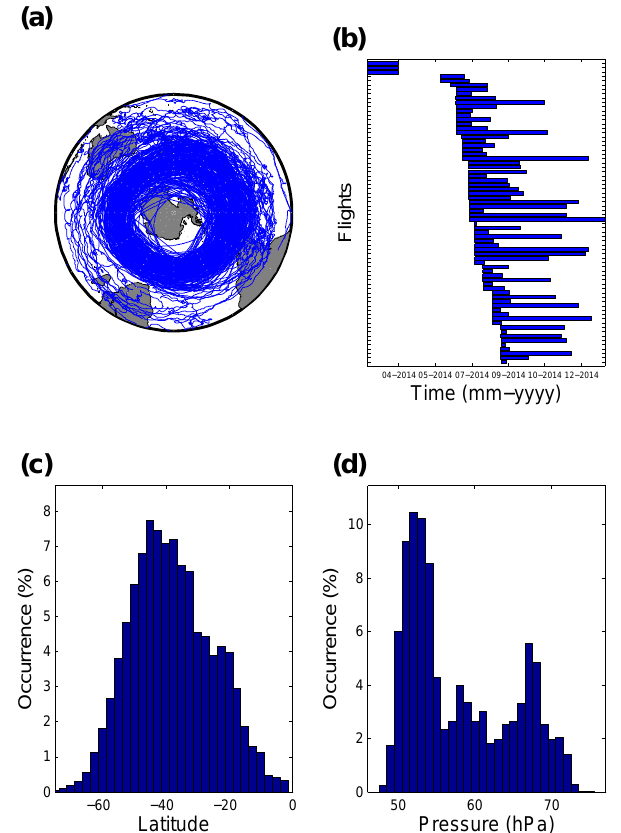
Figure 1. General Loon flight information including a (a) set of all balloon trajectories viewed from south pole, (b) timeline showing individual balloon launch times and flight durations, (c) histogram of observation distribution as a function of latitude, and (d) his- togram of observation distribution as a function of